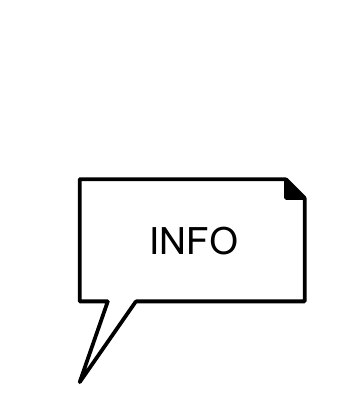
Figure 2.55: The Process Description glyph for annotation